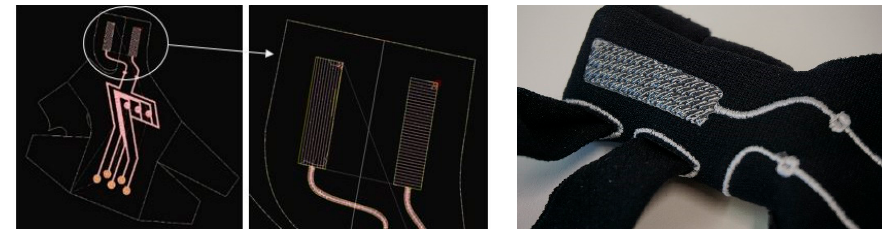
Figure 2. Piezoresistive textile bending sensor ( left : punch pattern, right : final bending